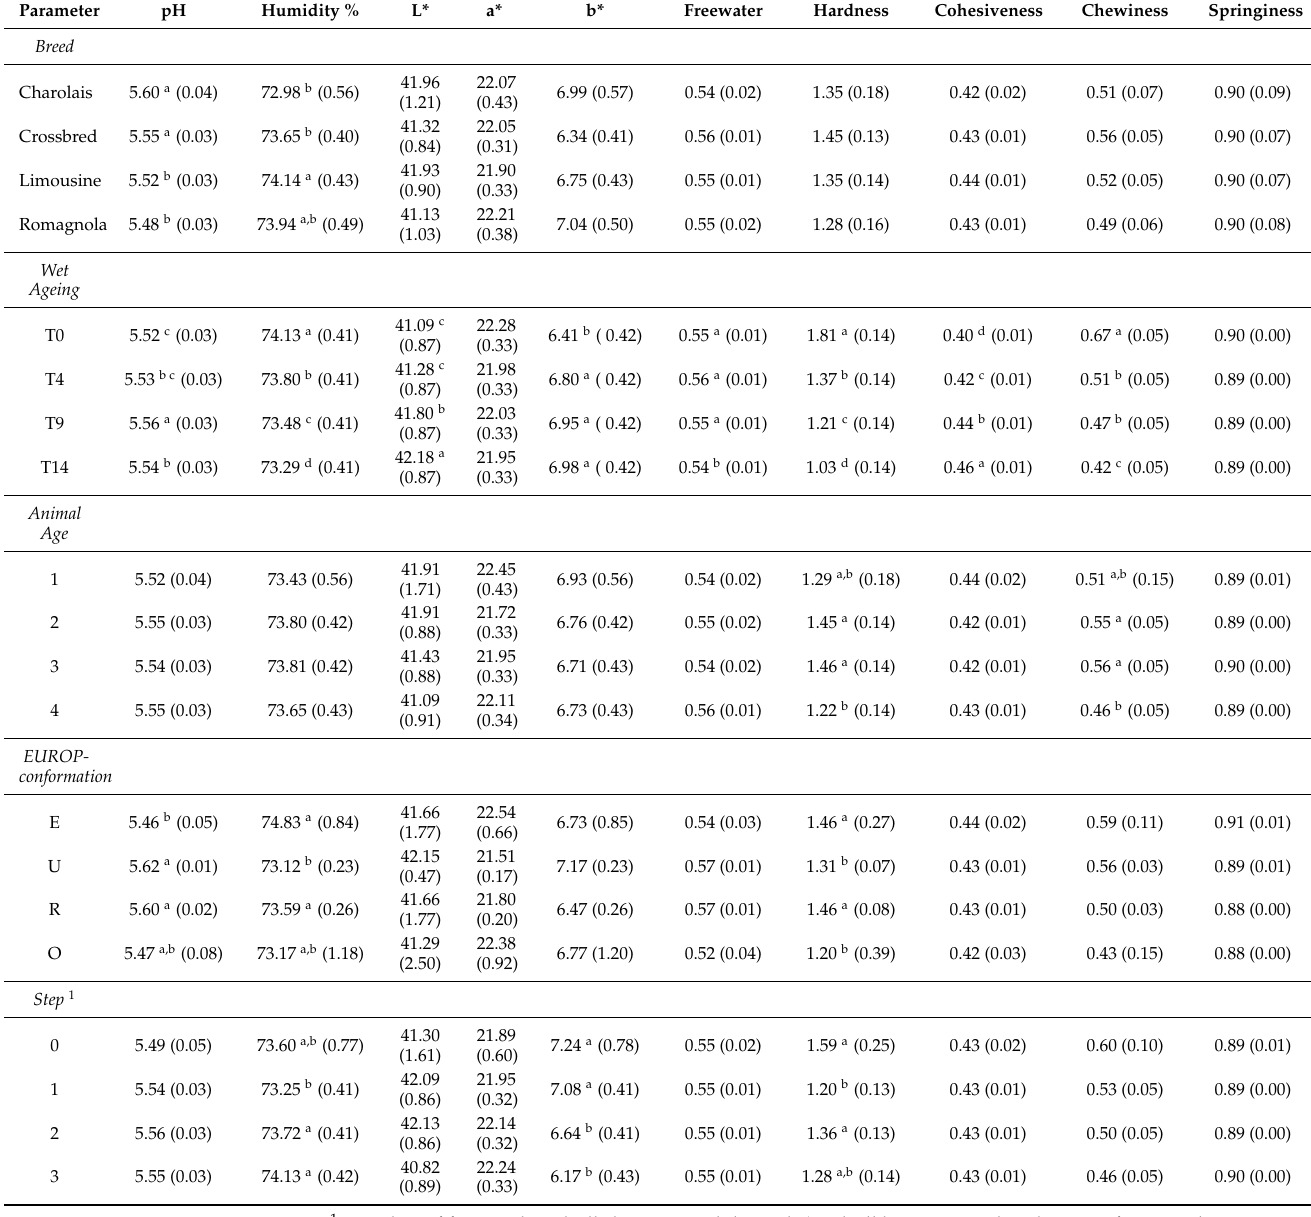
Table 3. Least squares means (SE in parentheses) of meat parameters considering all samples, where L* represents the lightness, a* the redness, and b* the